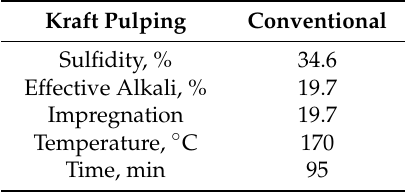
Table 1. Conventional pulping conditions